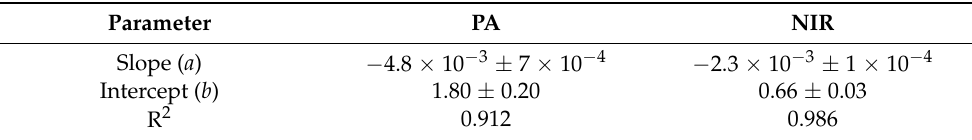
Table 2. Fitting parameters for the linear models ( y = ax + b ) presented in Figure 5, describing the imaging contrast reduction as a function of the overlying layer’s